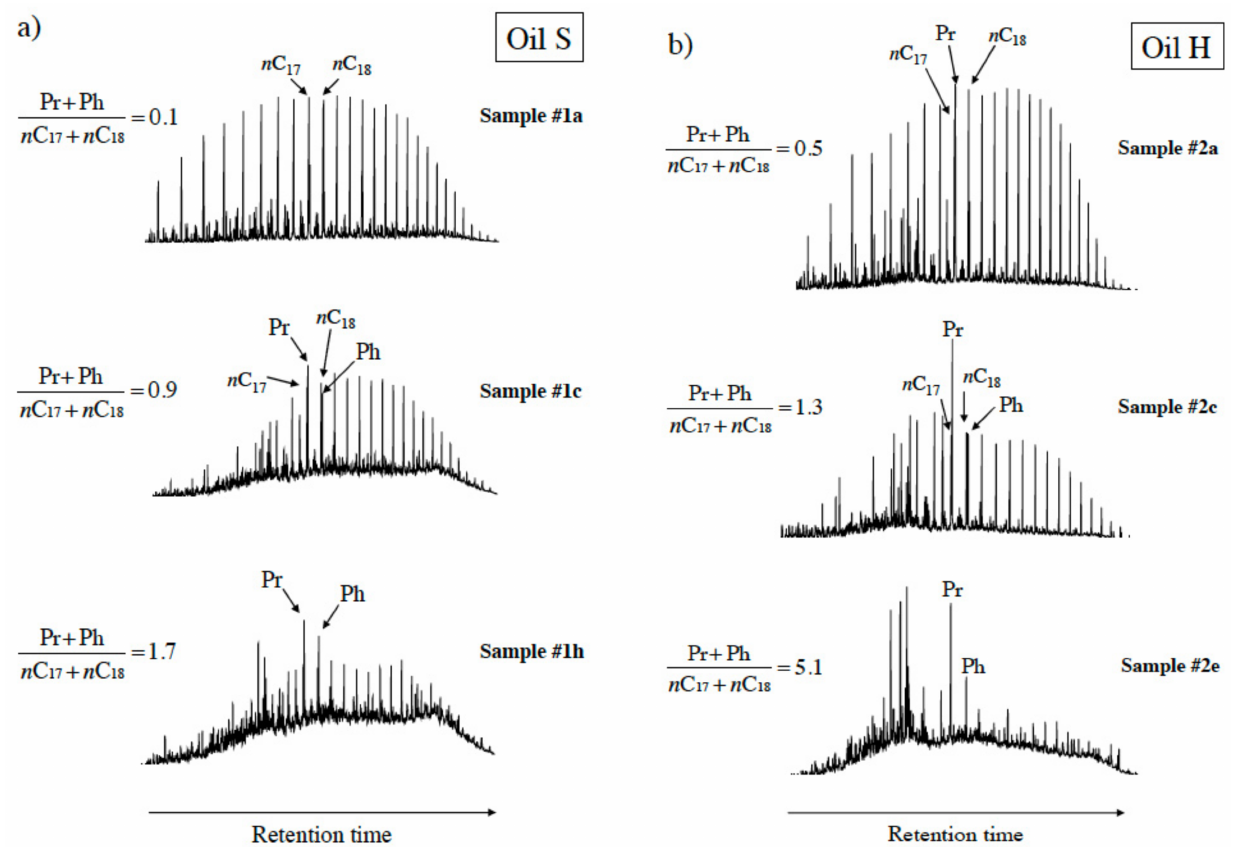
Figure 1. Total ion current traces of the saturate fraction from oils representing 3 stages of biodegradation of two sets of oil families ( a ) Oil S and ( b ) Oil H.